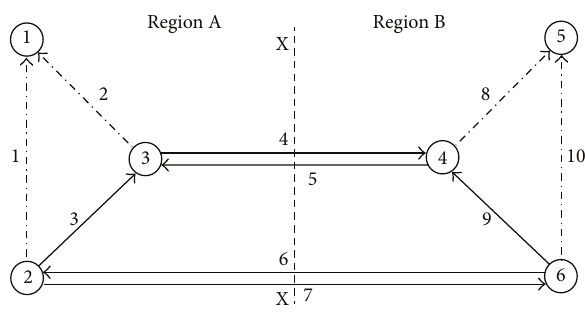
Figure 2: A small network for numerical examples.